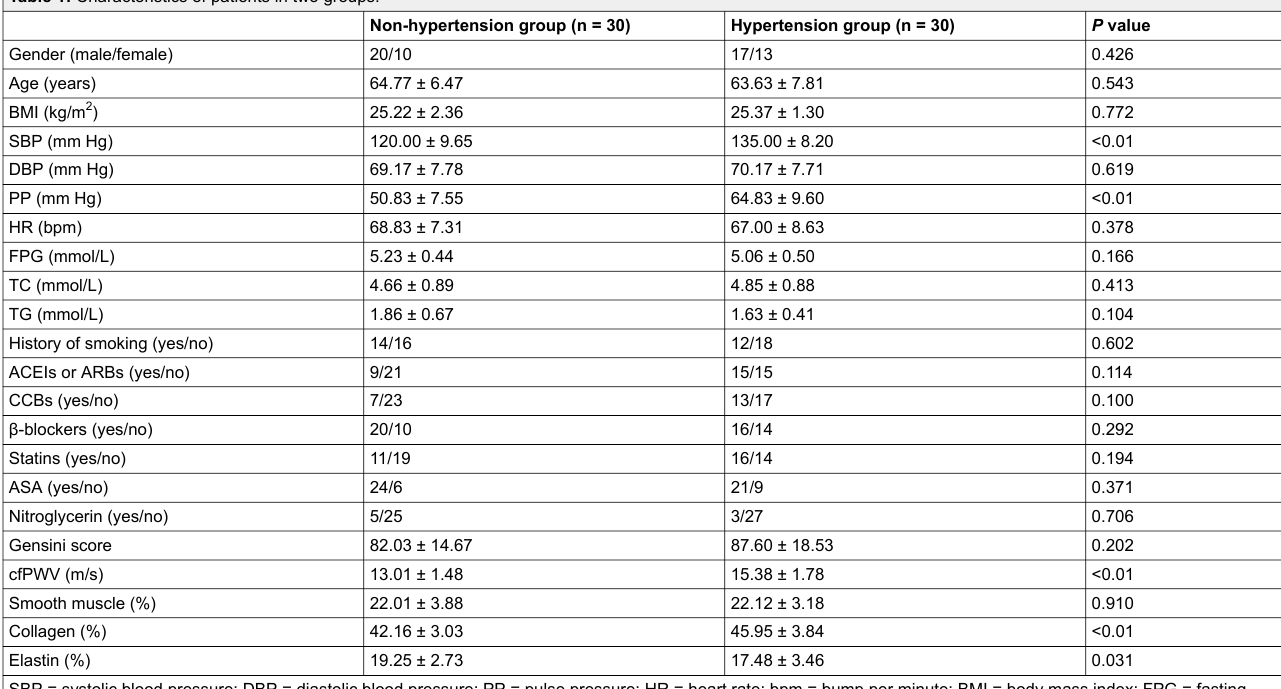
Table 1: Characteristics of patients in two